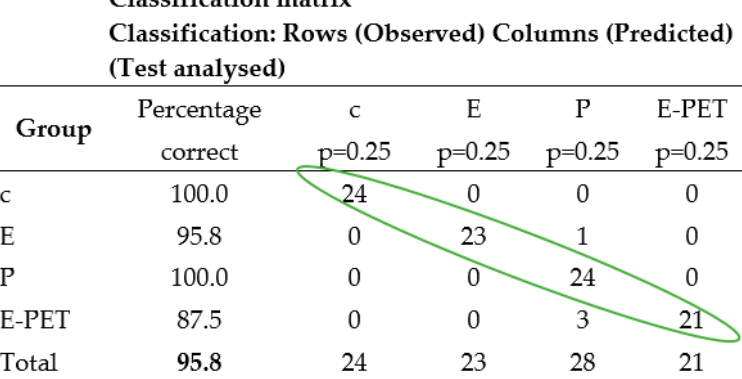
Figure 6. Classification matrix—training group.